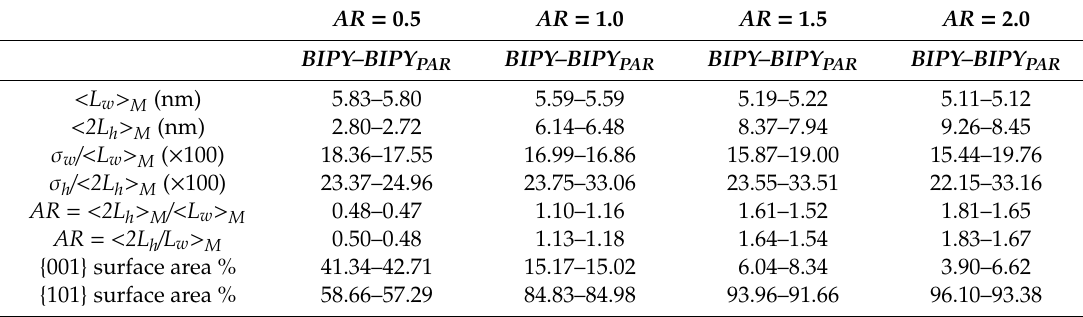
Table A1. Numerical results of the BIPY PAR model vs. the true BIPY values (graphically shown in Figure 3c).